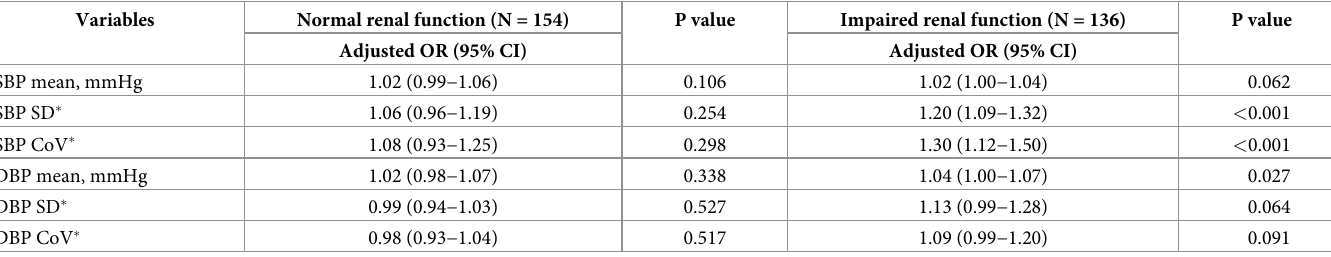
Table 3. Logistic regression analysis of BPV parameter as predictors for END according to renal function.